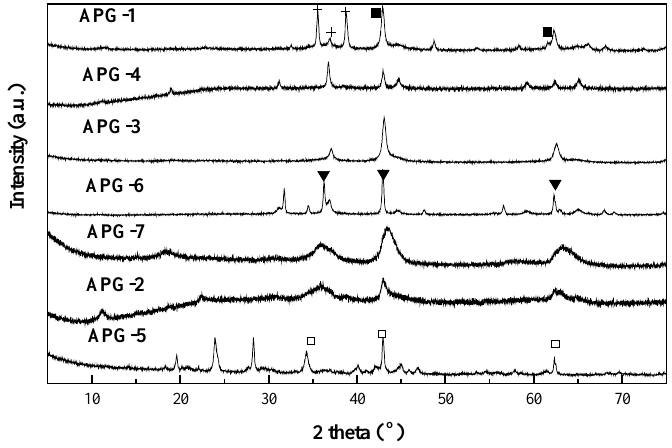
Figure 2. X-ray diffraction patterns of the mixed oxides derived from precursors after calcinating at 700 ˝ C. +: CuO, (cid:4) : Mg(Al)O; İ : ZnAl 2 O 4 , ˝ : BaAl 2 O 4 .